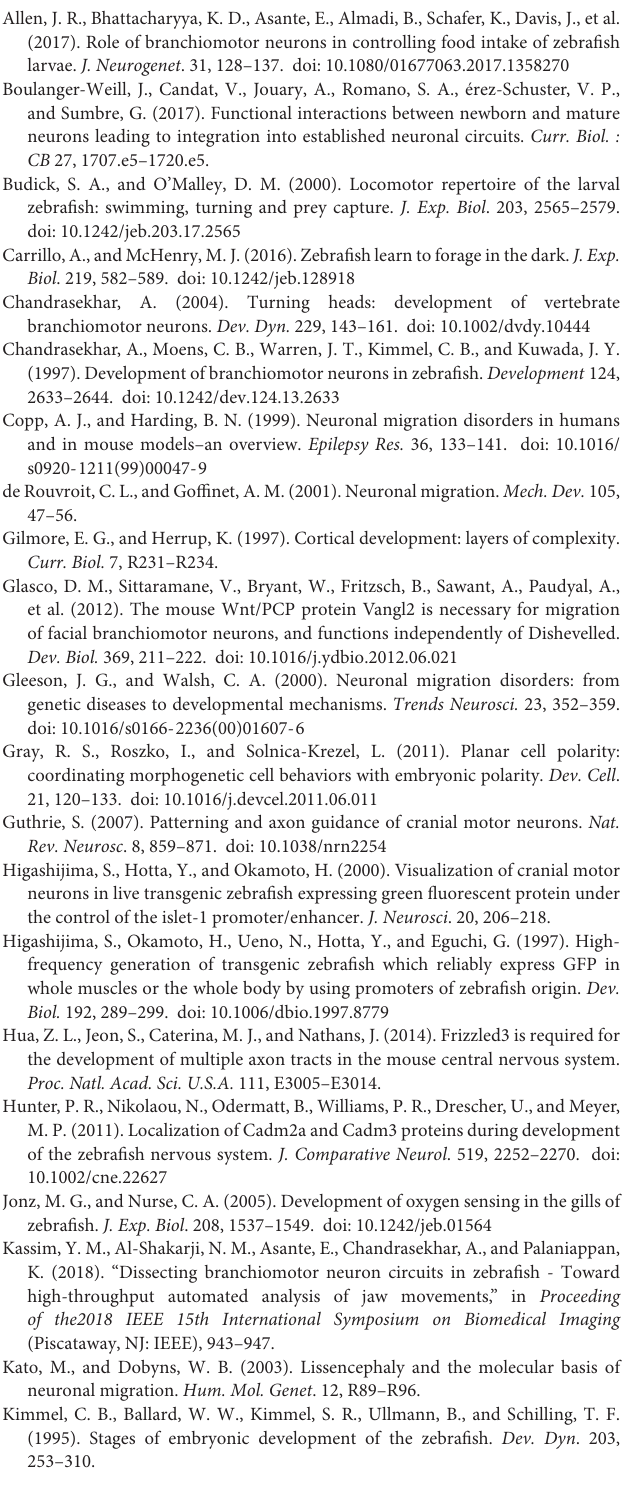
Supplementary Movie 7 | Dorsal view of the hindbrain of a 7 dpf wildtype sibling. Images of changes in Ca 2 + levels in branchiomotor neurons were obtained in the GFP channel at 2 frames per second for 5 min. Speeded up 12.5 × .